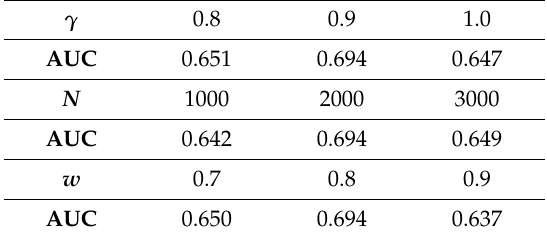
Table 2. Ablation study: Sensitivity to hyperparameters, γ in (8), N in Algorithm 1, and w in